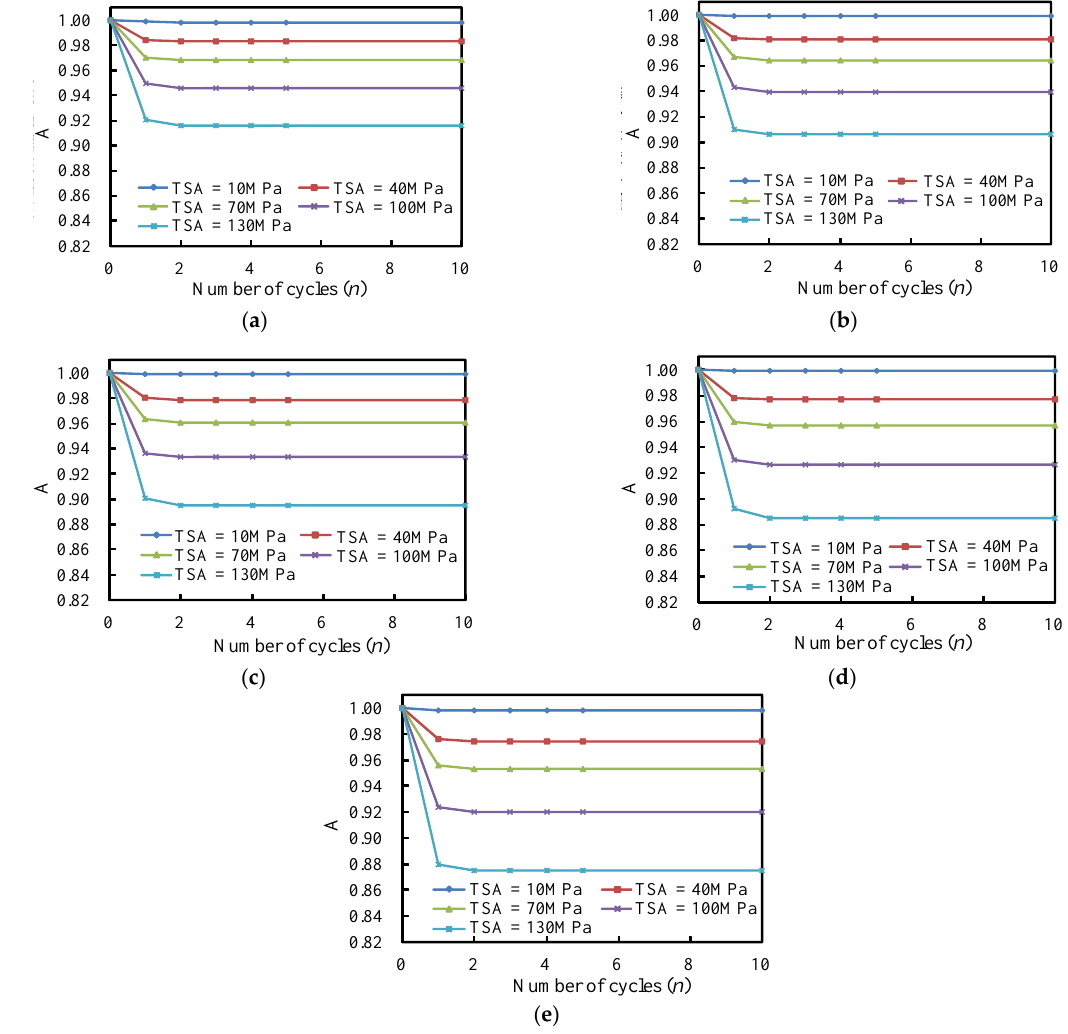
Figure 16. The variation curve of residual stress relaxation coefficient A with TSA: ( a ) R = –0.5; ( b ) R = –0.25; ( c ) R = 0; ( d ) R = 0.25; ( e ) R = 0.5.